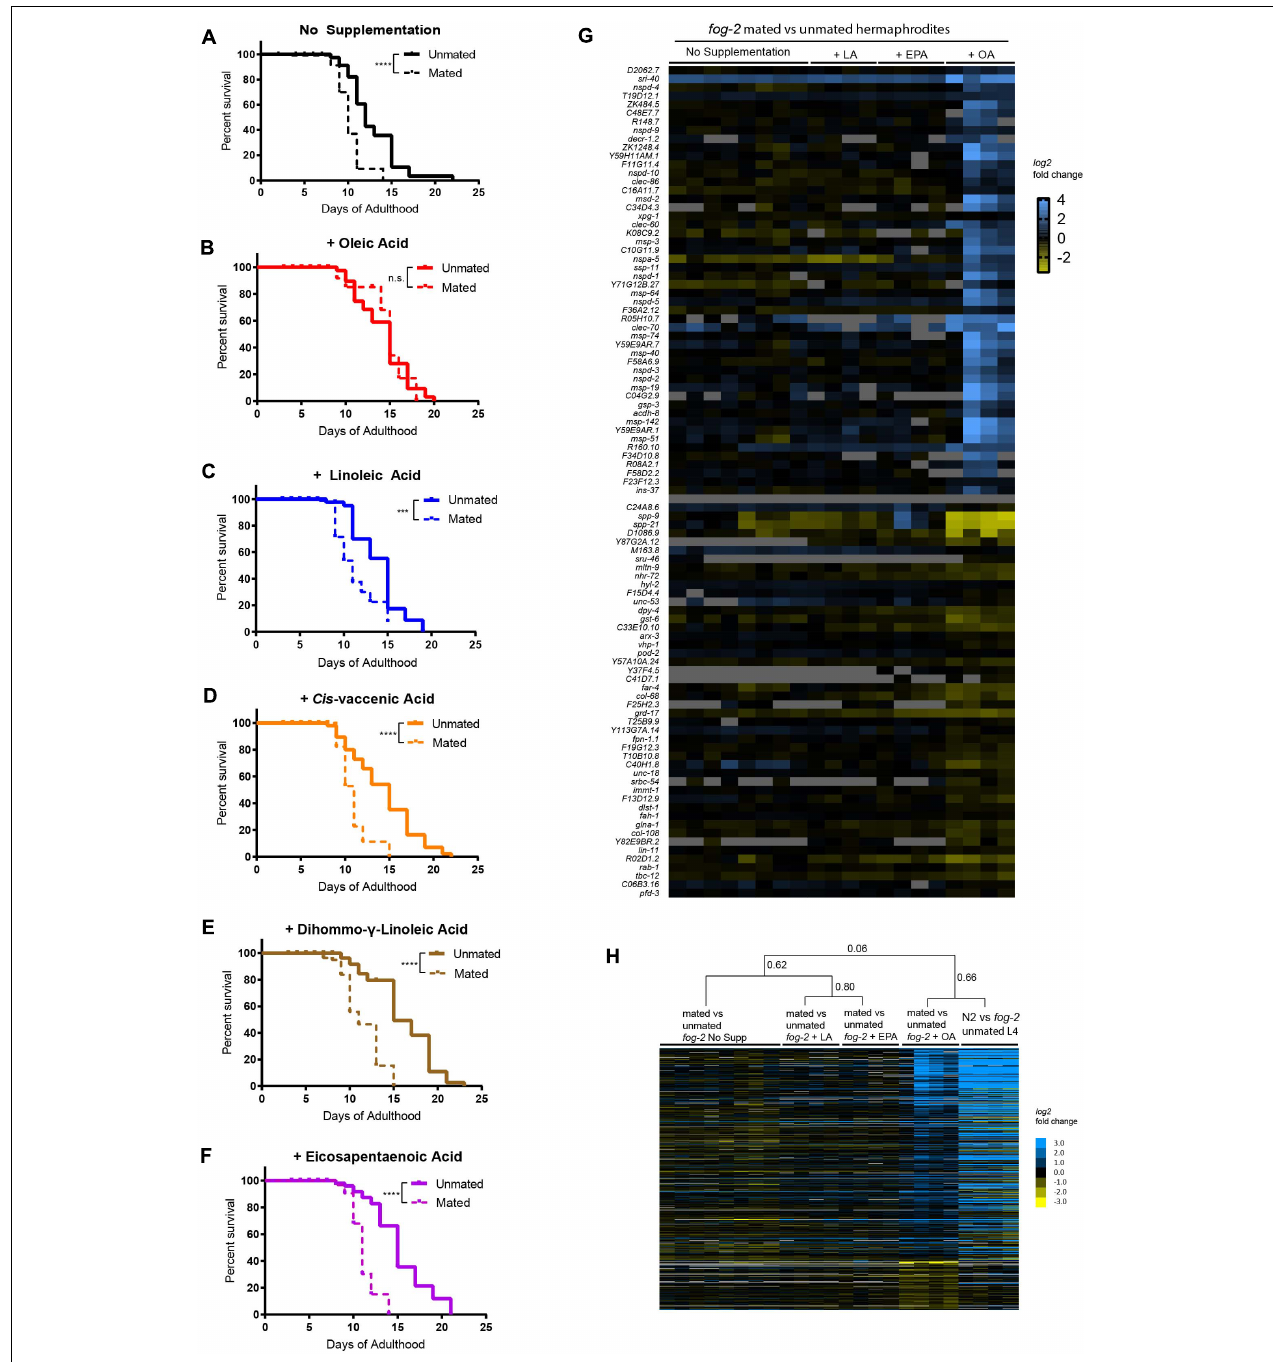
FIGURE 2 | Oleic acid supplementation rescues mating-induced death in wild-type C. elegans mothers. (A–F) Only oleic acid supplementation rescues lifespan loss induced by mating. N2 unmated: 12.7 ± 0.6 days, n = 60; mated: 9.4 ± 0.4 days, n = 100, p < 0.0001; unmated + OA: 14.2 ± 0.5 days, n = 60; mated + OA: 13.3 ± 1.2 days, n = 100, p = 0.8344; unmated + LA: 14.3 ± 0.6 days, n = 60; mated + LA: 10.2 ± 0.4 days, n = 100, p = 0.0007; unmated + VCA: 14.3 ± 0.6 days, n = 60; mated + VCA: 10.5 ± 0.3 days, n = 100, p < 0.0001; unmated + DGLA: 15.9 ± 0.6 days, n = 60; mated + DGLA: 9.8 ± 0.5 days, n = 100, p < 0.0001; unmated + EPA: 15.2 ± 0.5, n = 60; mated + EPA: 10.3 ± 0.4, n = 100, p < 0.0001. (G) Heatmap of top 50 genes that were significantly differentially expressed upon mating with oleic acid supplementation identified by two-class SAM analysis (Tusher et al., 2001). (H) Heatmap of differentially expressed genes identified by two-class SAM analysis comparing the transcriptomes of mated vs. unmated worms with oleic acid supplementation to all other conditions. The same list of genes was retrieved from published data (N2 vs. fog-2 unmated L4 hermaphrodites, Shi et al., 2019) and their heatmap were added on the right to show striking similarity. Hierarchical clustering of the arrays were performed by Cluster 3.0 (de Hoon et al., 2004) using centroid linkage method. Correlation coefficients are listed next to the corresponding branches/nodes.